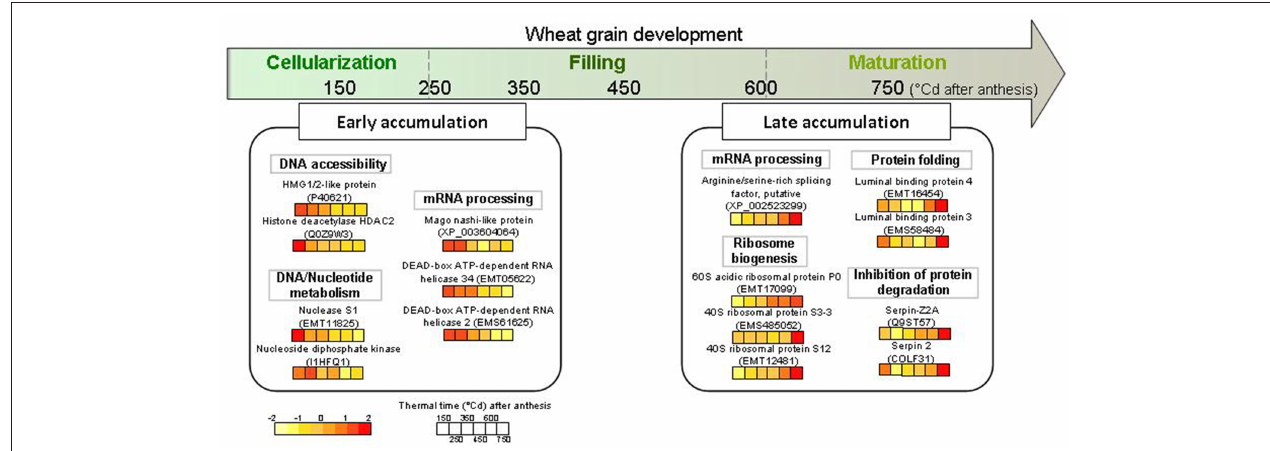
FIGURE 7 | Schematic view of some highlighted nuclear proteins accumulated during early and late grain development. These proteins were extracted from wheat grain at six thermal times after anthesis, from 150 to 750 ◦ Cd and analyzed on 2-D gel electrophoresis. The color code for normalized volume of correspondent protein spots is indicated at the bottom